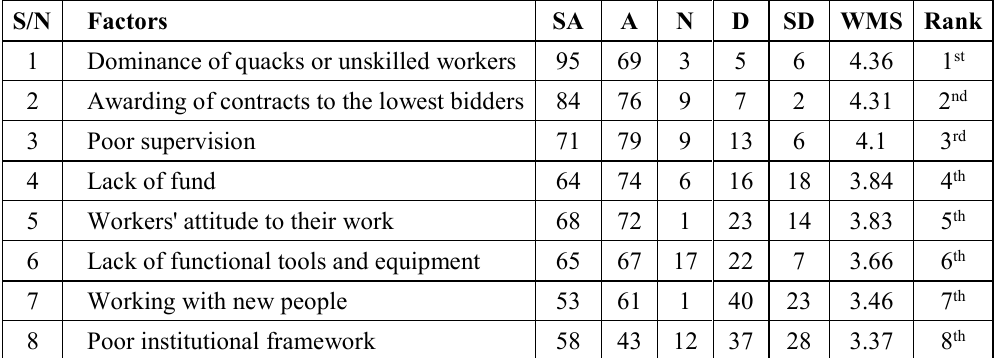
Table 7. Barriers to Quality Assurance Management in Housing Delivery Process